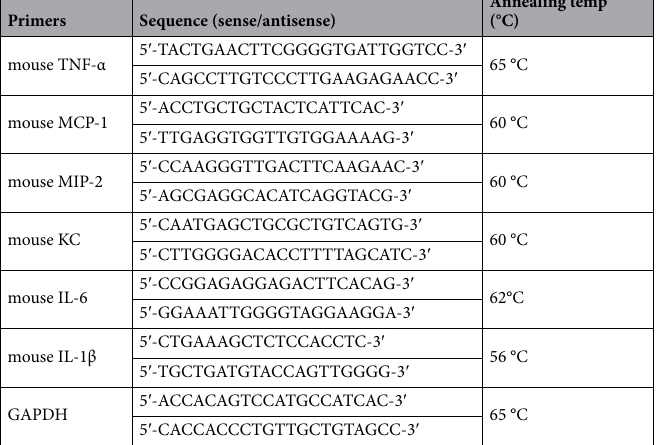
Figure 3A, B show